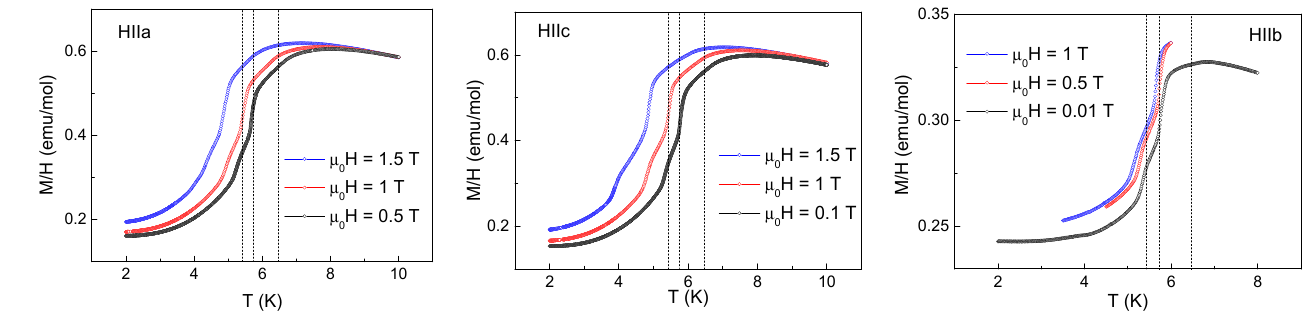
Figure 3. Temperature dependences of M / H taken at various external magnetic fields along principal crystallographic axes in TbTe 3 . Vertical dash lines denote temperatures of magnetic phase transitions at T N1 , T N2, and T N3 .